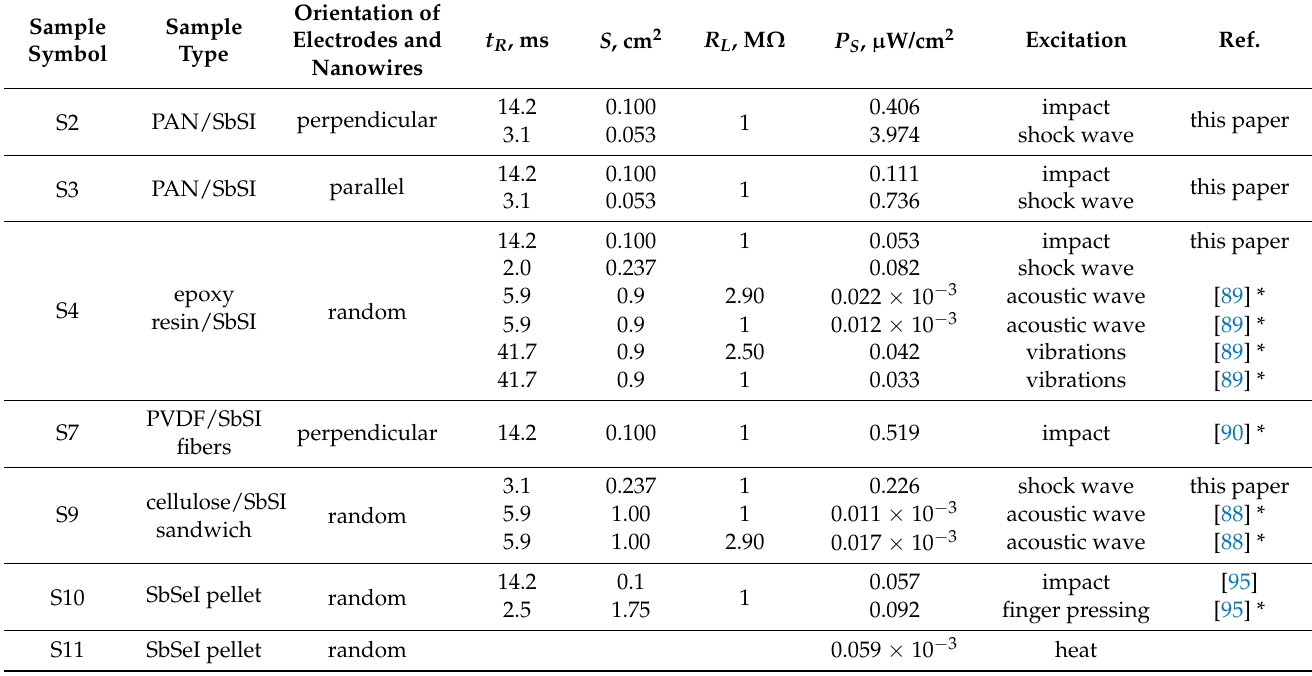
Table 3. All the values used in the calculations of the surface power density and the obtained results. The symbols are defined in the